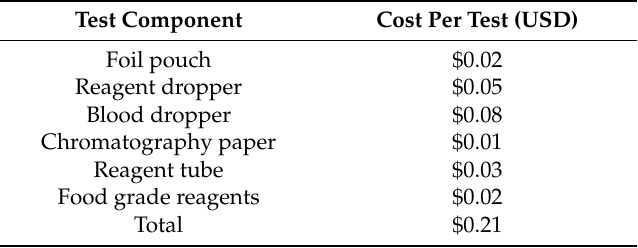
Table 1. Detailed cost breakdown of the paper-based SCA screening test kit